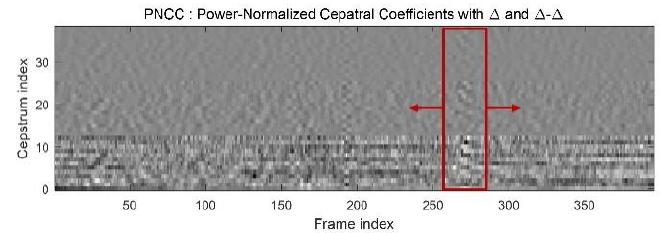
Figure 8. Target data generation using data augmentation.